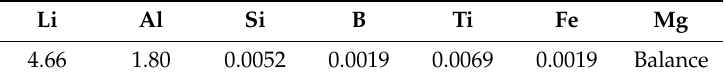
Table 1. The chemical composition of the alloy (wt.%).